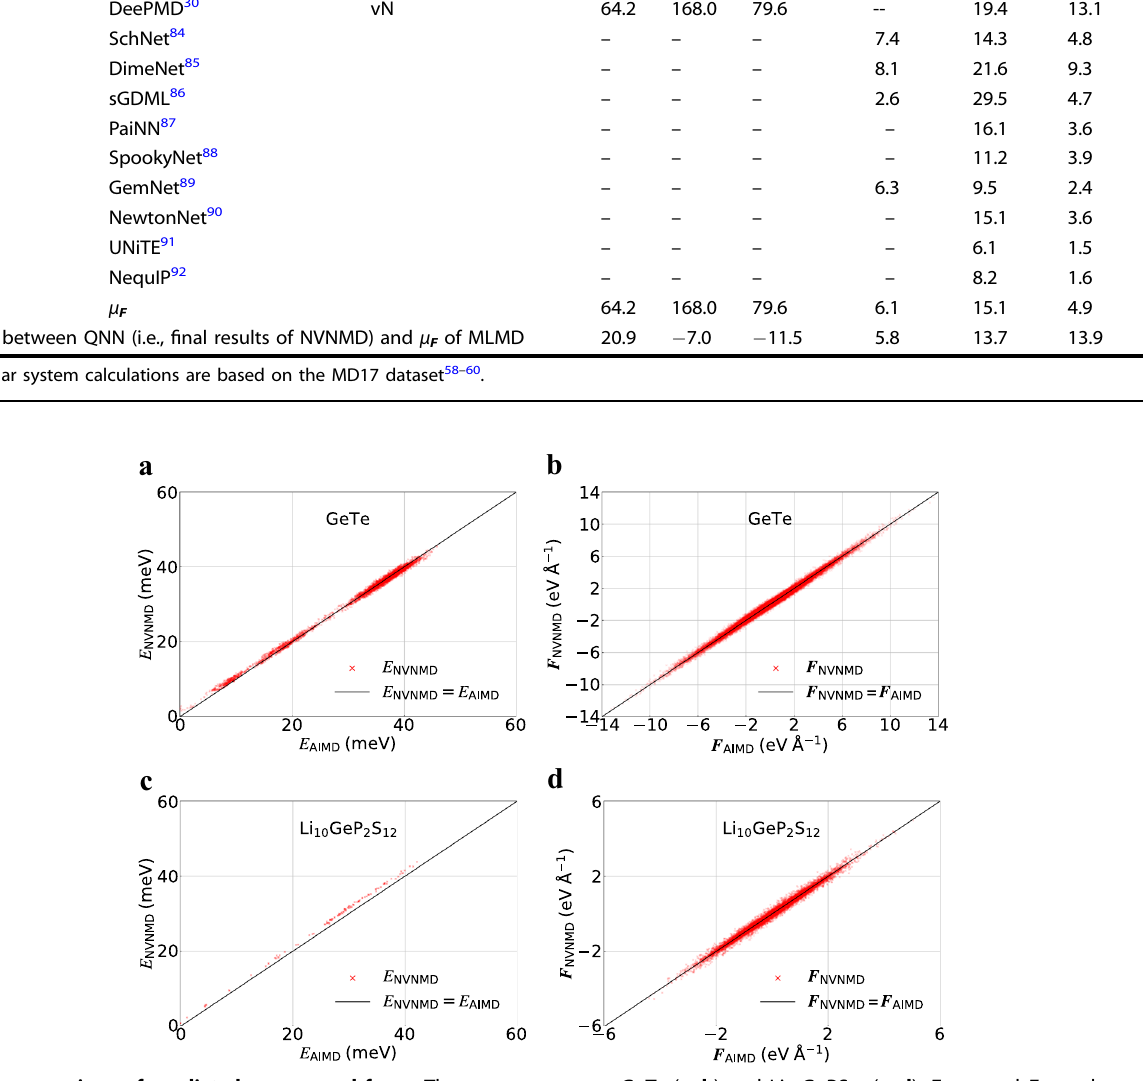
Fig. 1 The comparison of predicted energy and force. The test systems are GeTe ( a , b ) and Li 10 GePS 12 ( c , d ). E AIMD and F AIMD denote the energy and atomic forces of the AIMD samples. E NVNMD and F NVNMD denote the energy and atomic forces evaluated by NVNMD